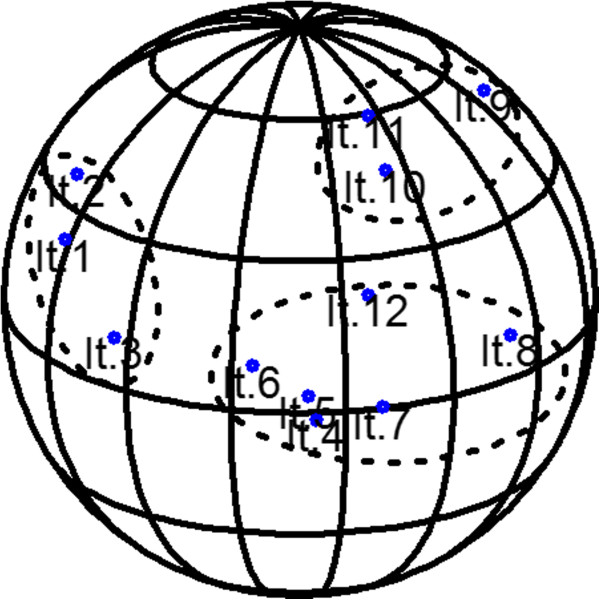
Three-dimensional diagram of the correlation matrix among the various items on the scale (N = 517). All items on the scale could be depicted on the same side of the sphere.